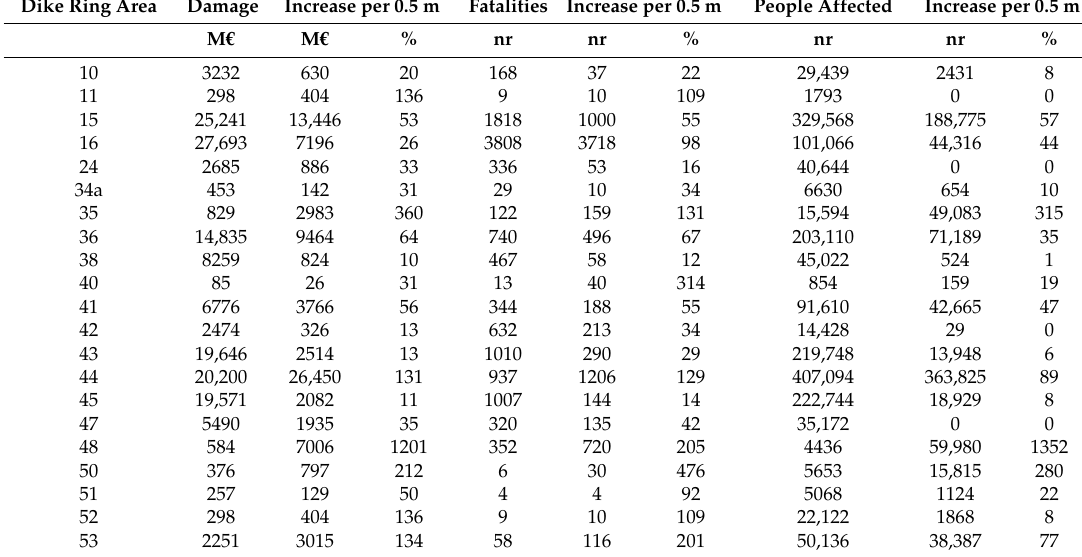
Table 1. Consequence increase that would result in The Netherlands’ dike ring areas from 0.5 m higher flood levels in case climate change impacts on river flood levels would not be counteracted by largest